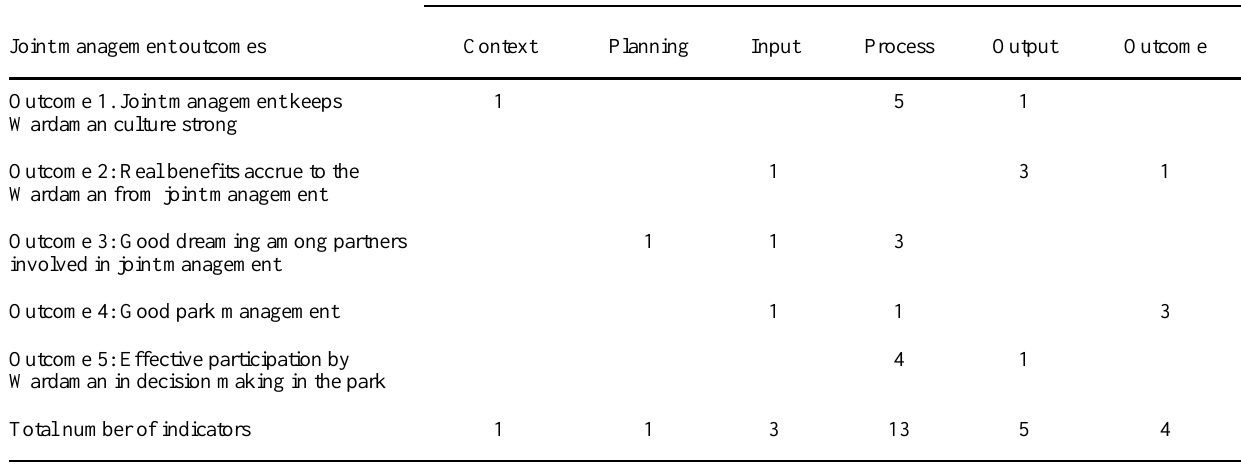
Table 2 . Classification of joint management indicators for Flora River Nature Park based on the World Commission on Protected Areas framework for assessing management effectiveness of protected areas (Hockings et al. 2006) Number of indicators by management effectiveness category Joint management outcomes Context Planning